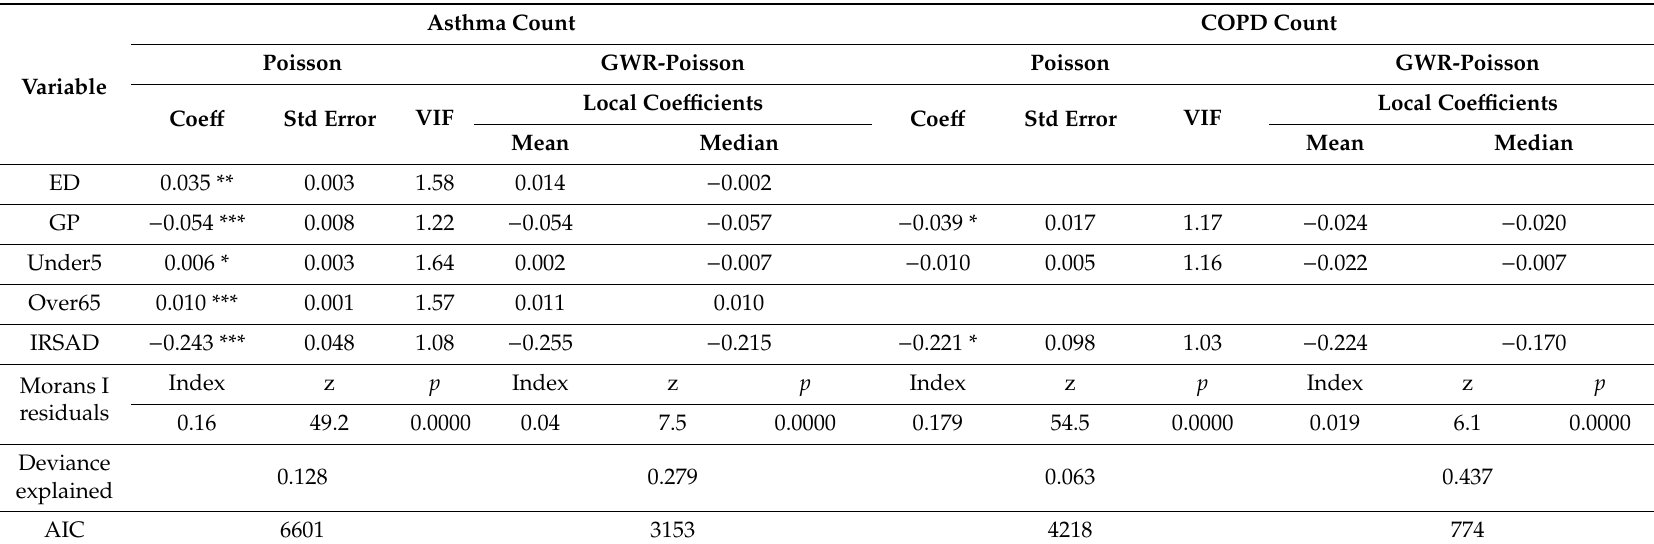
Table 3. Summary of regression